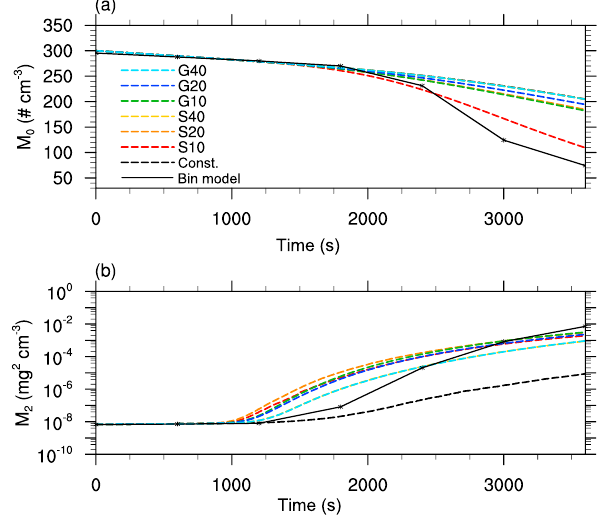
Figure 6. Moments of the mass density distribution as a function of time obtained from single-box simulations. The black solid line denotes the solution of Wang et al. (2007), the black dashed curve for the reference simulation (without splitting). The colored dashed curves show the solutions for different splitting configurations.